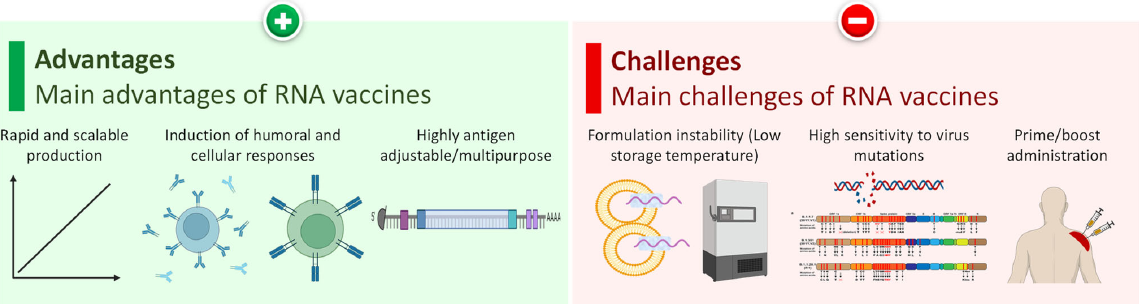
Figure 13. Typical structure of lipid nanoparticle-encapsulated mRNA encoding spike protein. Redrawn from [107].